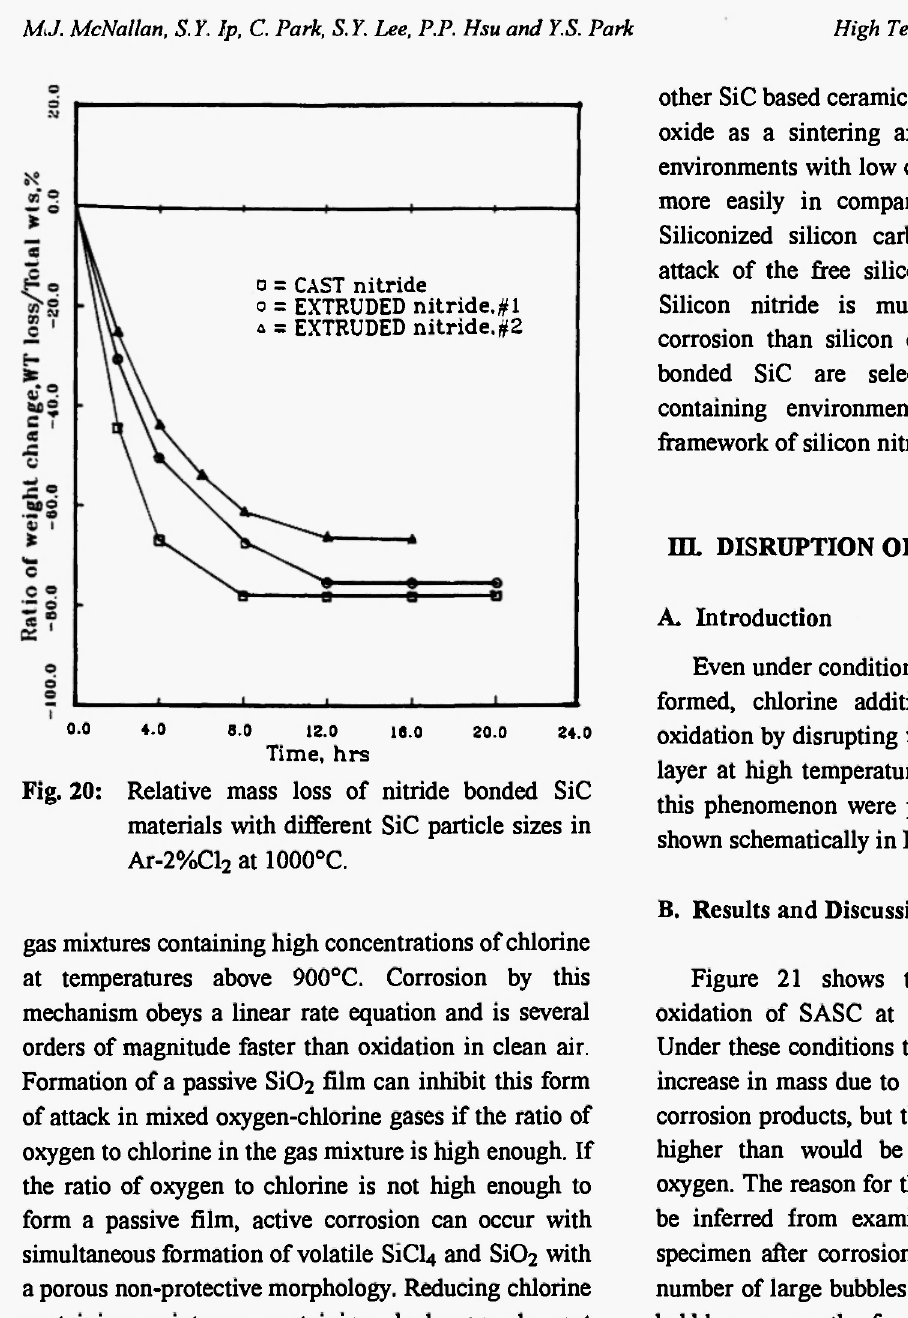
Fig. 20: Relative mass loss of nitride bonded SiC materials with different SiC particle sizes in Ar-2%C1 at 2